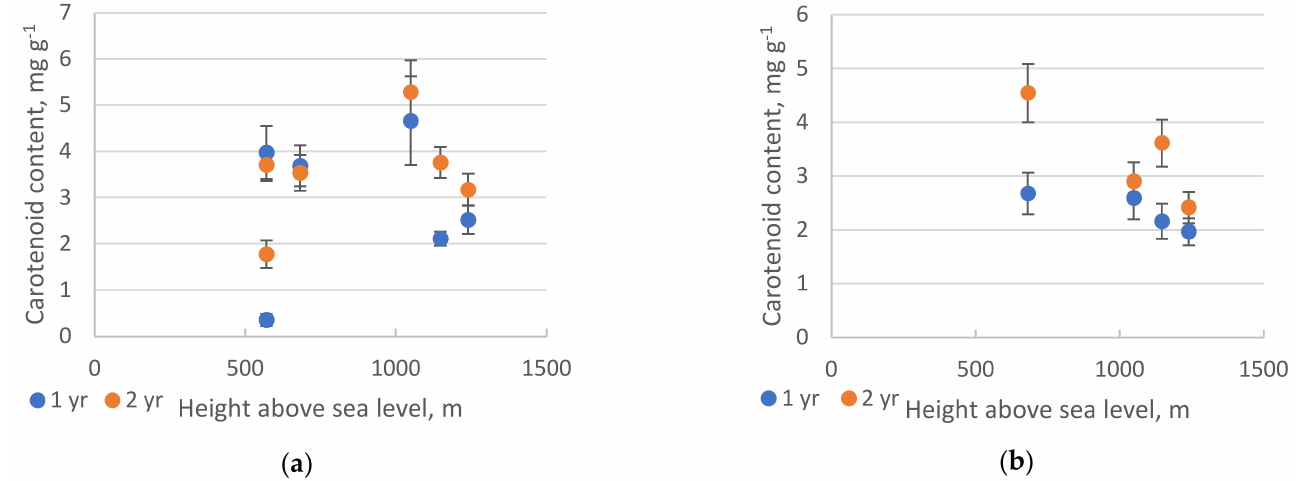
Figure 5. Content of carotenoids (dry weight) in needles of P. sibirica ( a ) and A. sibirica ( b ). Pearson analysis did not reveal any significant linear regression in either species ( p > 0.05). The vertical bars represent the standard deviation. At each sample point, four measurements of both one– and two–year–old needles were